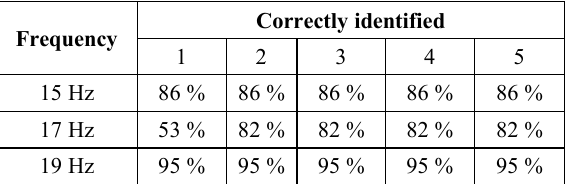
Table 6. ANN classifier test results.